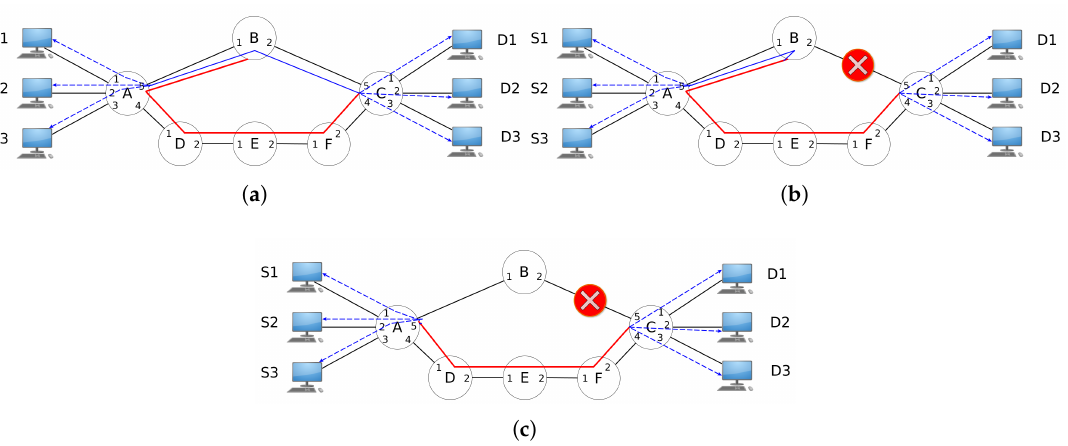
Figure 4. LONG dynamics before and after a link failure. ( a ) LONG before the link B-C failure. Path [A, B, C] is protected. ( b ) LONG after the link B-C failure (proactive protection). ( c ) LONG after the protection and restoration phases are